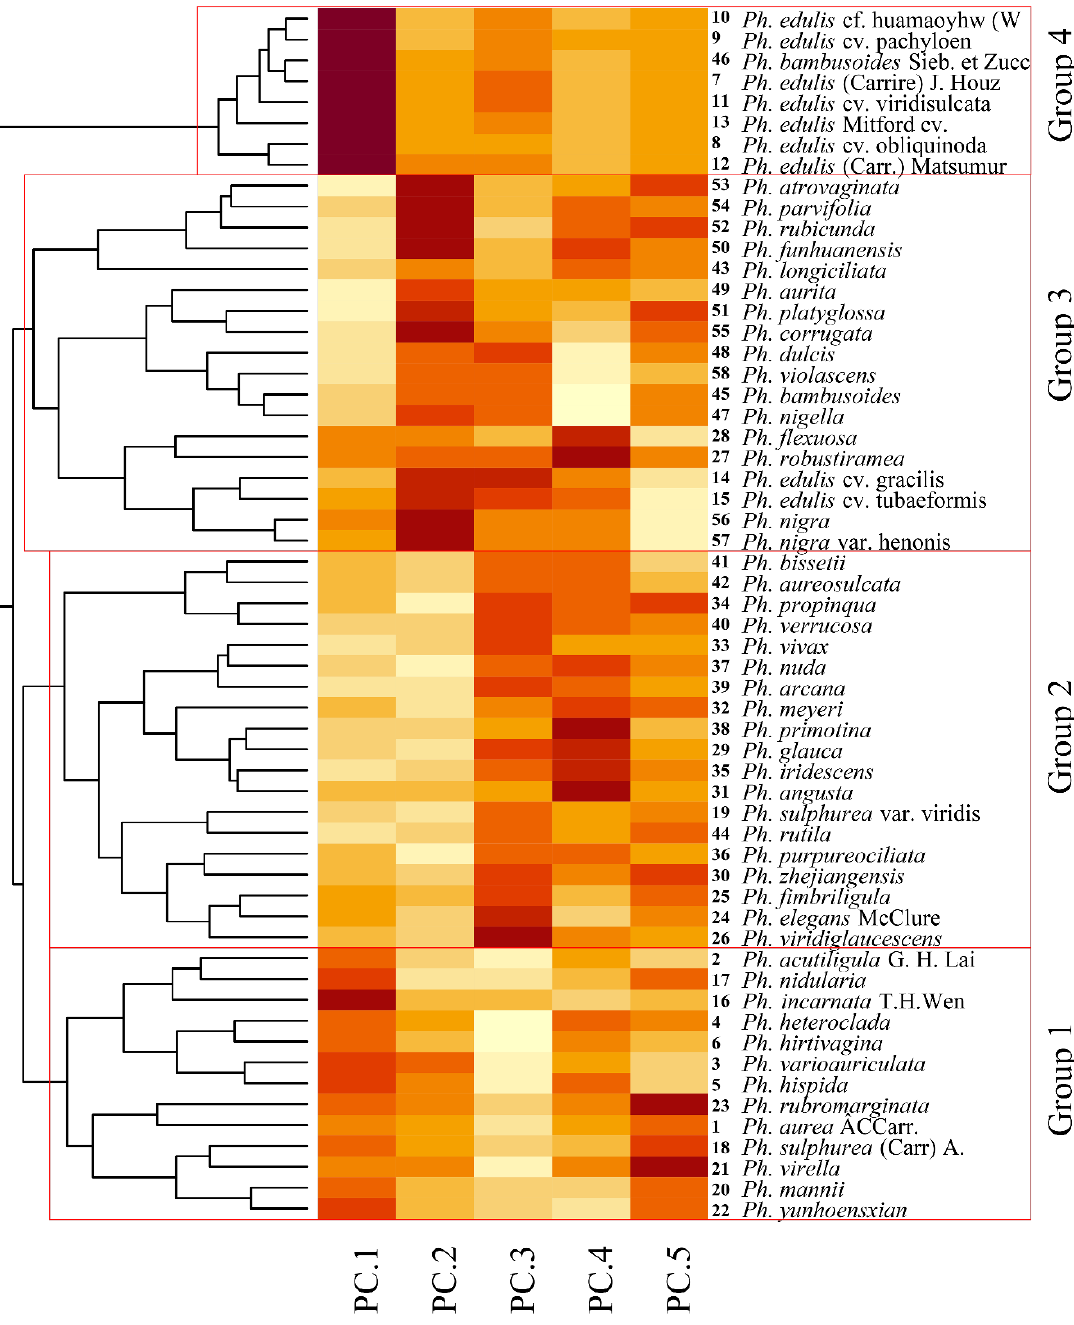
Figure 6. Heatmap of principal component analysis (PCA) showing the distribution of 58 Phyllostachys species (Asian bamboo) based on inter-retrotransposon amplified polymorphism (IRAP) markers. Five significant principal components (PCs) were identified based on the broken-stick model. Hierarchical clustering was done using Euclidean distances. Numbers 1–58 on the right side represent different Asian bamboo species as defined in Table 1.